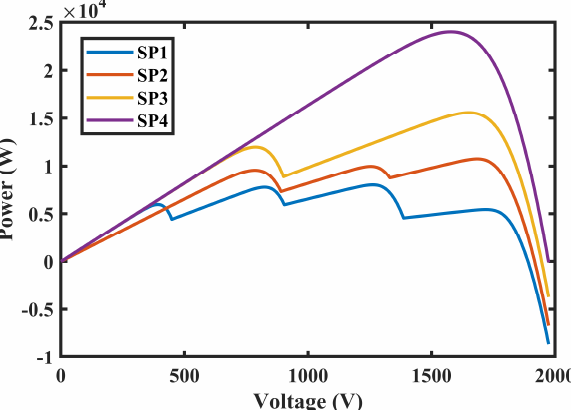
Figure 9. P ‐ V curves at different SPs.